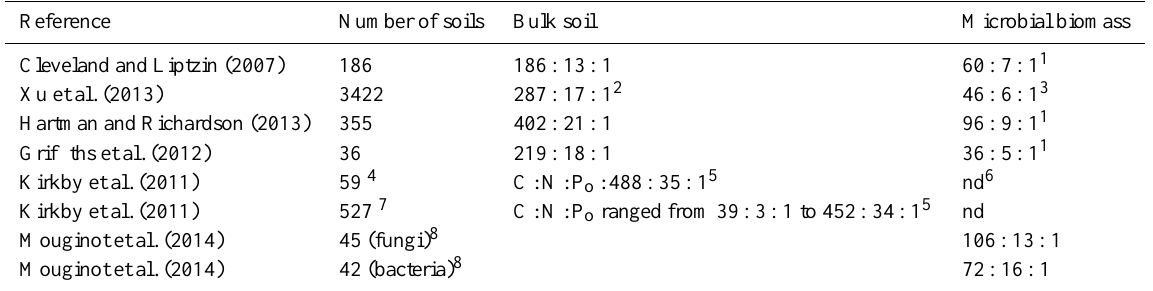
Table 1. Average C:N:P molar ratios in bulk soil (total C, total N, and total P, unless otherwise mentioned) and in soil microbial biomass reported in selected